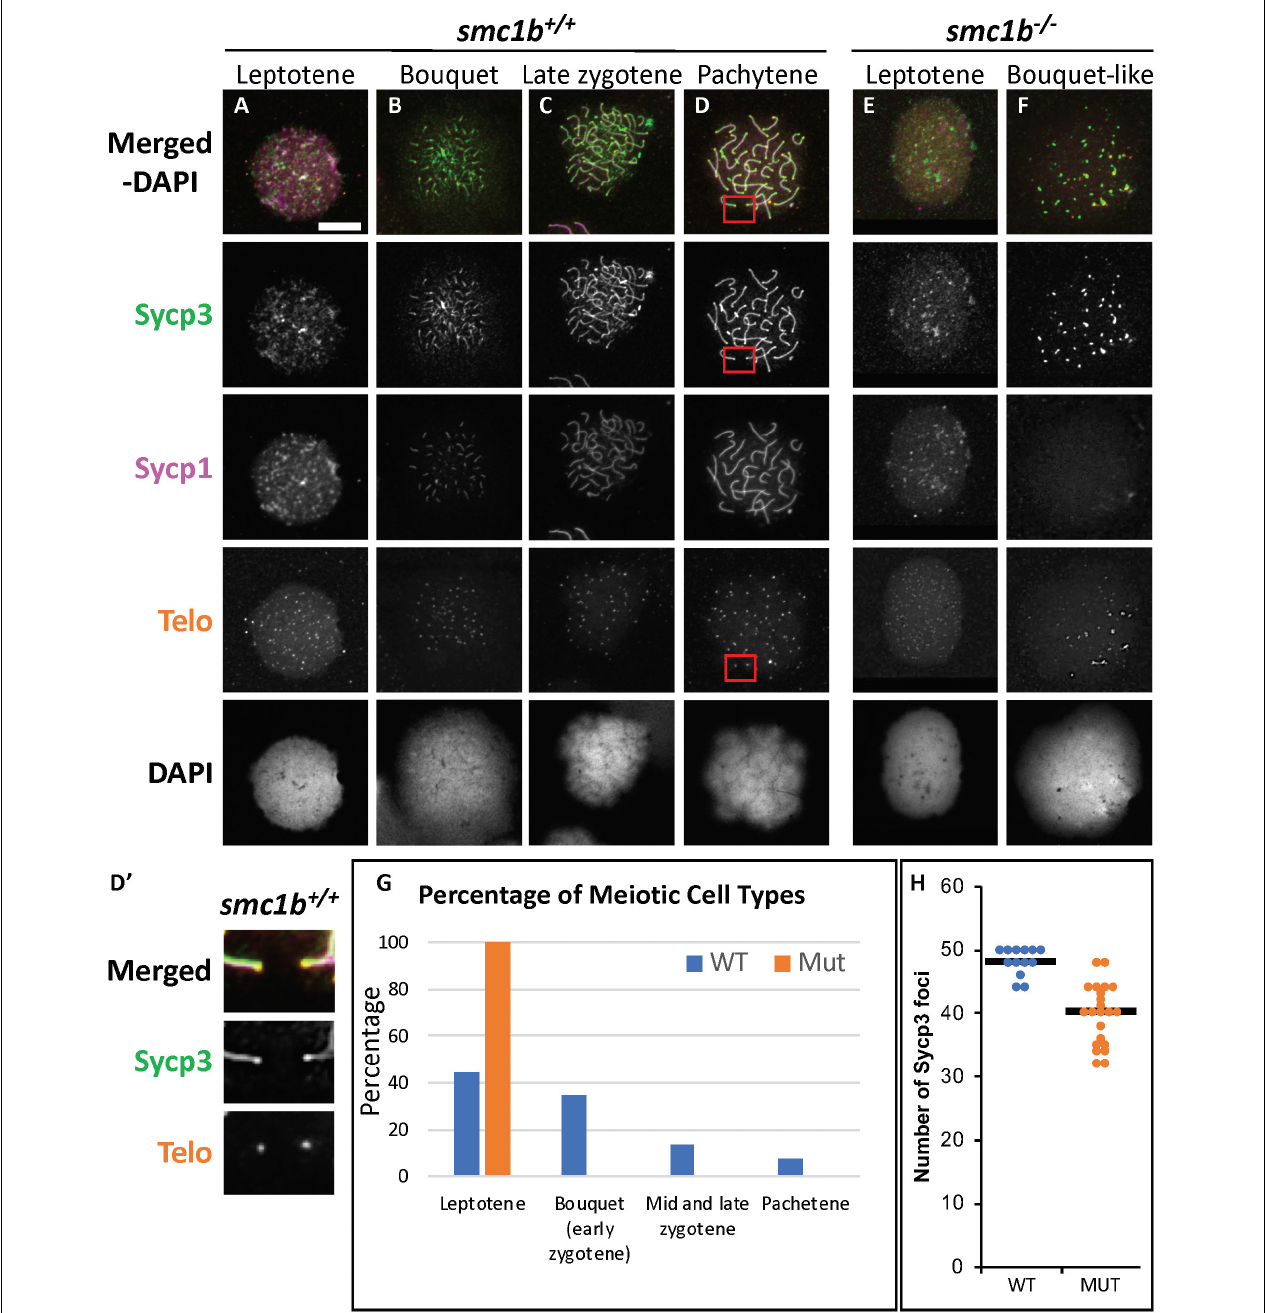
FIGURE 5 | Failed synapsis and anomalous pairing in smc1b Q198X mutant spermatocytes. (A–F) Labeling of Sycp3 and Sycp1 proteins and telomeres (telo) on meiotic chromosome spreads from adult testes. (A–D) In wild-type spermatocytes, leptotene stage cells had Sycp3 protein localized near chromosome ends and exhibited either no Sycp1 signal or Sycp1 puncta. The synaptonemal complex proteins continued to assemble between homologous pairs through pachytene stages as homolog pairing and synapsis occurred. (D (cid:48) ) Sycp3 exhibited enrichment at or near telomeres. Images show enlarged views of the red boxed areas in D. (E,F) Smc1b mutant spermatocytes leptotene stage cells expressed Sycp3 in with a pattern similar to that of wild-type leptotene stage cells and Sycp1 was either absent or present in puncta. However, Sycp3 only labeled chromosomes near the ends and Sycp1 did not extend along chromosomes. A small percentage of mutant cells exhibited some telomere clustering one side of the nucleus (F) , which we called bouquet-like and classified as leptotene stage as there was either no Sycp1 or only Sycp1 puncta visible. (G) Quantification of spermatocytes showed that all mutant cells are in leptotene stage compared to about 40% in wild type. Later stages were not observed in the mutants ( N = 52 wild-type and 130 mutant cells). (H) Quantification of Sycp3 foci in wild-type bouquet ( N = 13) and mutant “bouquet-like” ( N = 23) nuclei shows abnormal pairing in smc1b mutant spermatocytes. Mutants have significantly fewer Sycp3 puncta than wild types ( T -test, p = 0.000007). Horizontal bars in (H) show the averages. Scale bar is 10 µ m.